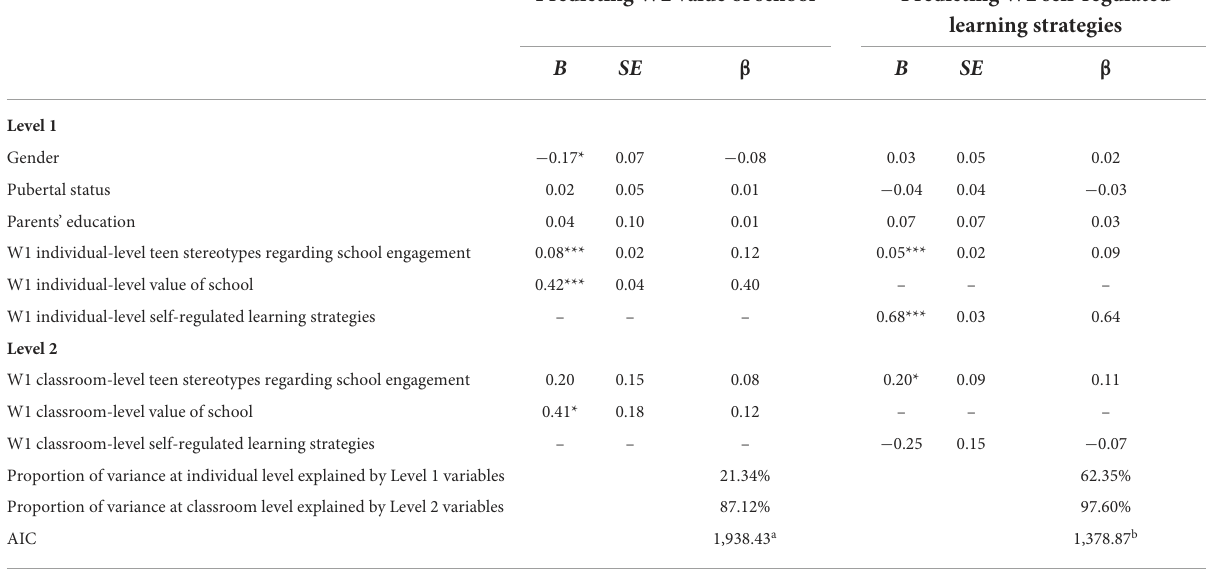
TABLE 3 Multilevel modeling predicting academic adjustment from teen stereotypes regarding school